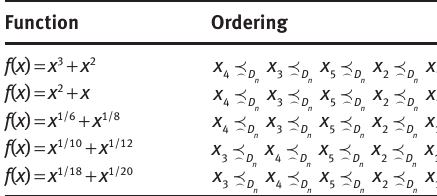
Table 5: Results of Ranking. Function